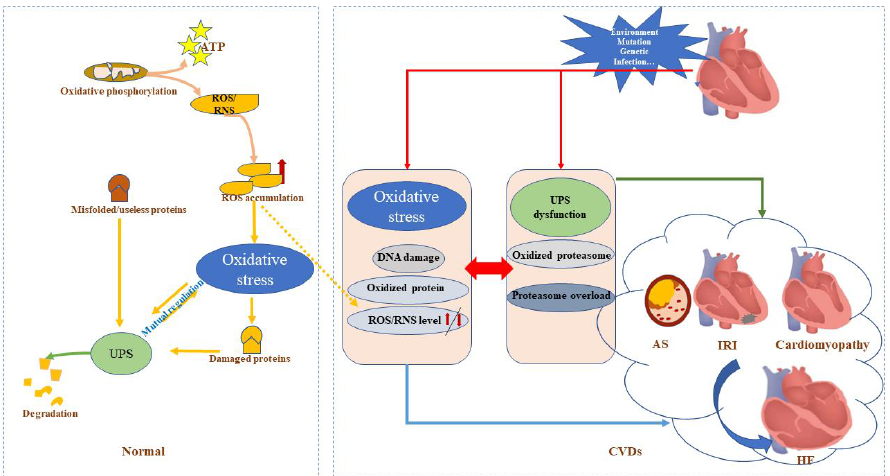
Figure 1. General schematic illustration of the relation among the ubiquitin – proteosome system (UPS), oxidative stress, and cardiovascular diseases (CVDs). Left : Oxidative phosphorylation produces ATP and ROS, triggering the UPS to degrade the proteins exposed to oxidative damage along with misfolded proteins; thus, mutual regulation mechanisms are at play between the UPS and oxidative stress. Right : The function and/or structure of the heart can be affected by gene mutation, heredity, infection, environmental exposures, and other factors, leading to a series of pathophysiological changes or protein modifications, including oxidative stress and ubiquitination. UPS can degrade the proteins damaged by oxidative stress; however, UPS dysfunction can directly lead to CVDs. Ubiquitination of antioxidant-system-related proteins can further upregulate the levels of reactive oxygen species (ROS)/reactive nitrogen species (RNS) to aggravate oxidative damage. Oxidative stress can directly damage UPS-related proteins leading to abnormal UPS function. Oxidative stress can also overload the UPS, yielding cardiac abnormalities such as atherosclerosis (AS), ischemia – reperfusion injury (IRI), cardiomyopathy, and heart failure (HF).